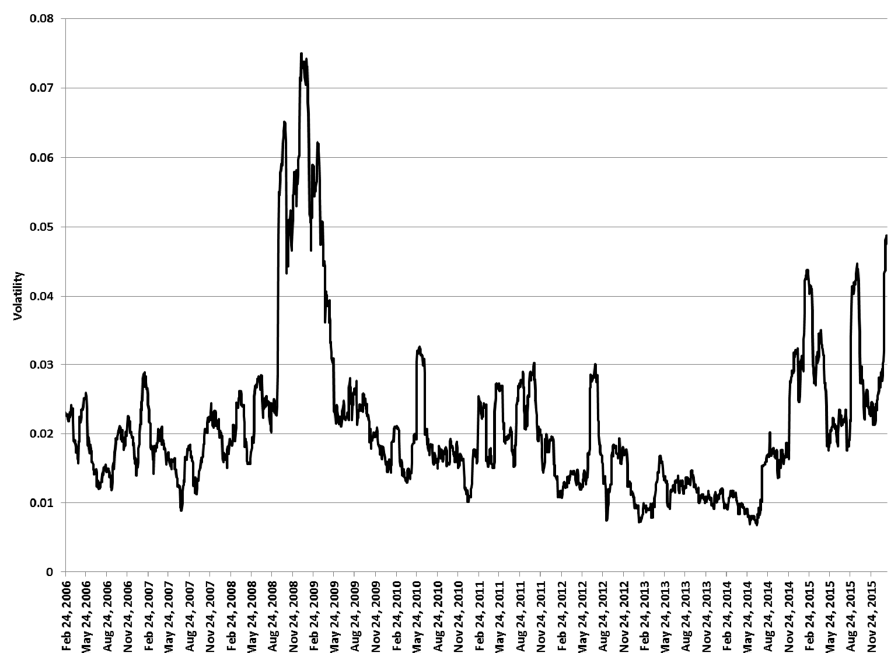
Figure 5. WTI crude oil price volatility (25-day moving window). Table 2. Parameter estimates as of the last sample day (4 February 2016).